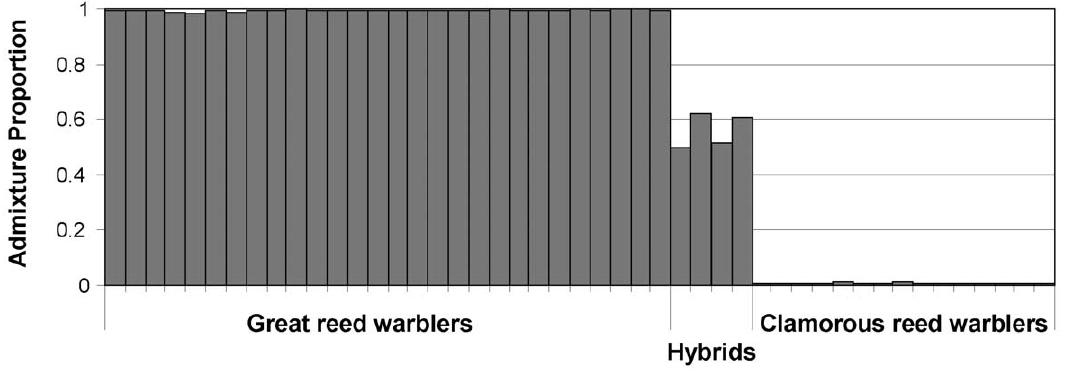
Figure 1. Admixture proportions of great reed warblers, clamorous reed warblers and hybrids in a sympatric breeding population in Kazakhstan to two genetic clusters generated from admixture models using the Bayesian genetic clustering technique implemented in S TRUCTURE .